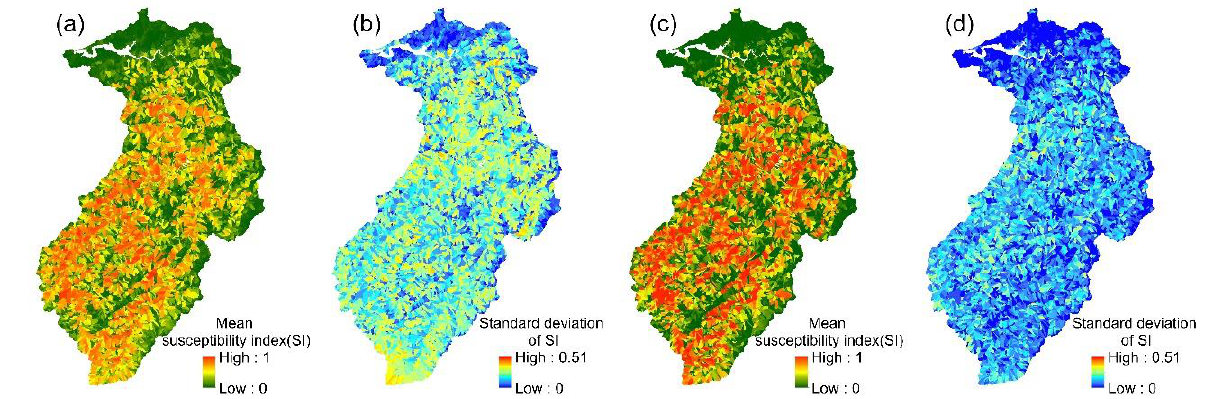
Figure 12. CA ensemble models: ( a , b ) the mean susceptibility index and standard deviation of 24